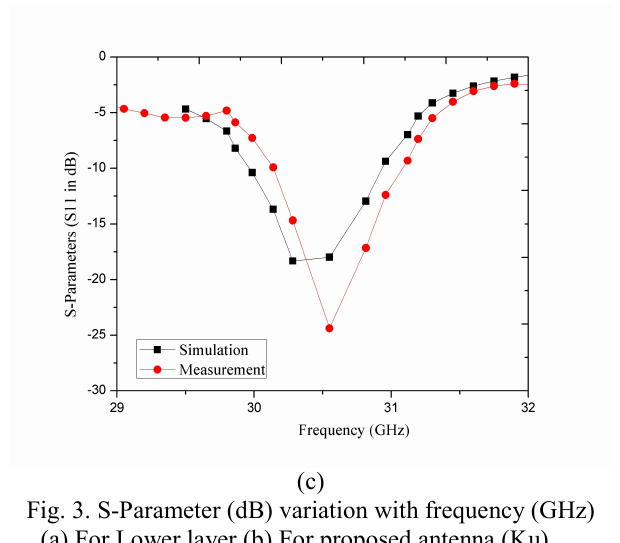
Fig. 3. S-Parameter (dB) variation with frequency (GHz)